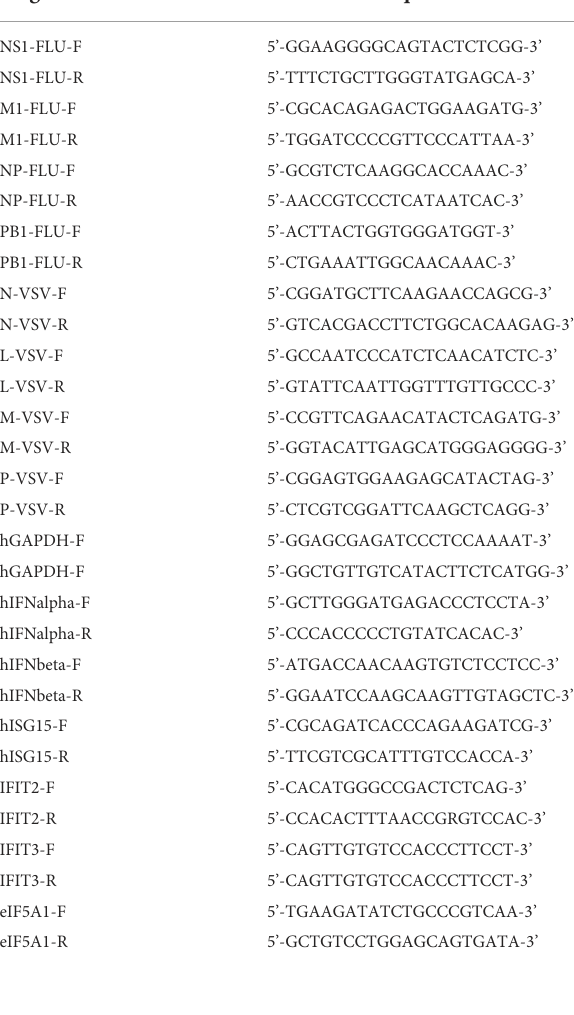
TABLE 1 Oligonucleotides used for